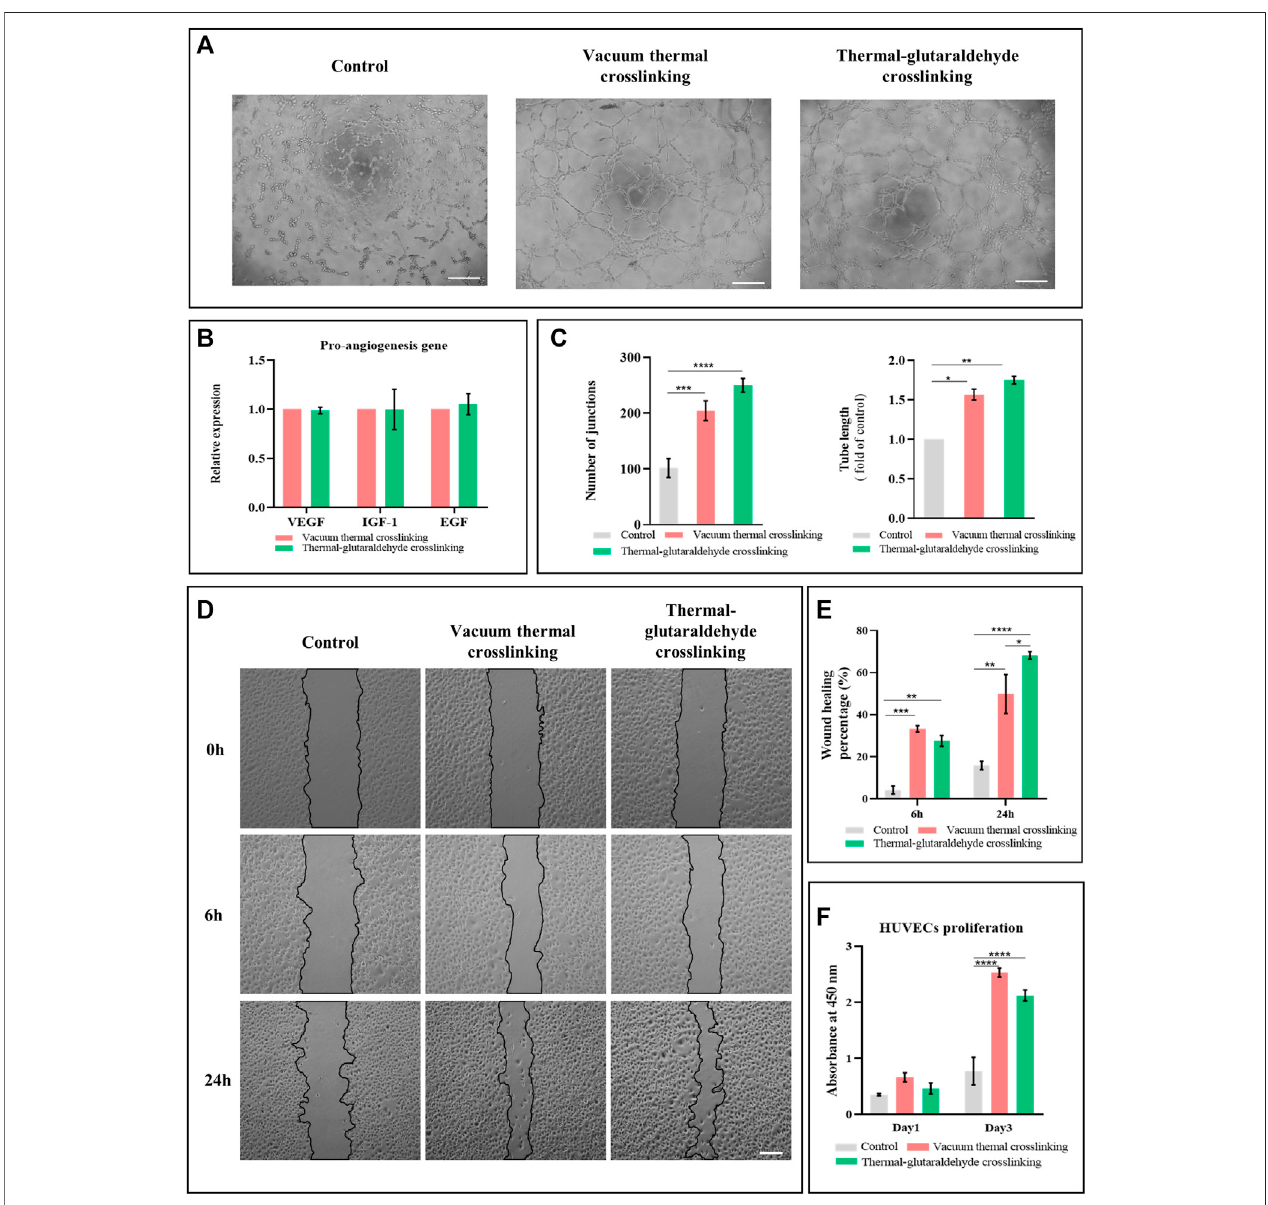
FIGURE 4 | Pro-vascular ability of VT-ADM and GA-ADM in vitro . (A) Tube formation induced by conditional medium and blank medium at 4 h, bar = 200 μ m. (B) Pro-angiogenesis gene expression levels of VT-ADM and GA-ADM ( n = 3 for each group). (C) Statistical analysis of the number of junctions and total tube length of the tube formation at 4 h ( n = 3 for each group). (D) Wound healing test induced by conditional medium and blank medium at 0, 6, and 24 h, bar = 200 μ m. (E) Wound healing percentage at 6 and 24 h in three groups (control, VT-ADM, and GA-ATM groups, n = 3 for each group). (F) HUVEC proliferation cultured in conditional media and blank medium on days 1 and 3 ( n = 3 for each group). *p < 0.05 , **p < 0.01 , ***p < 0.001 , and ****p <